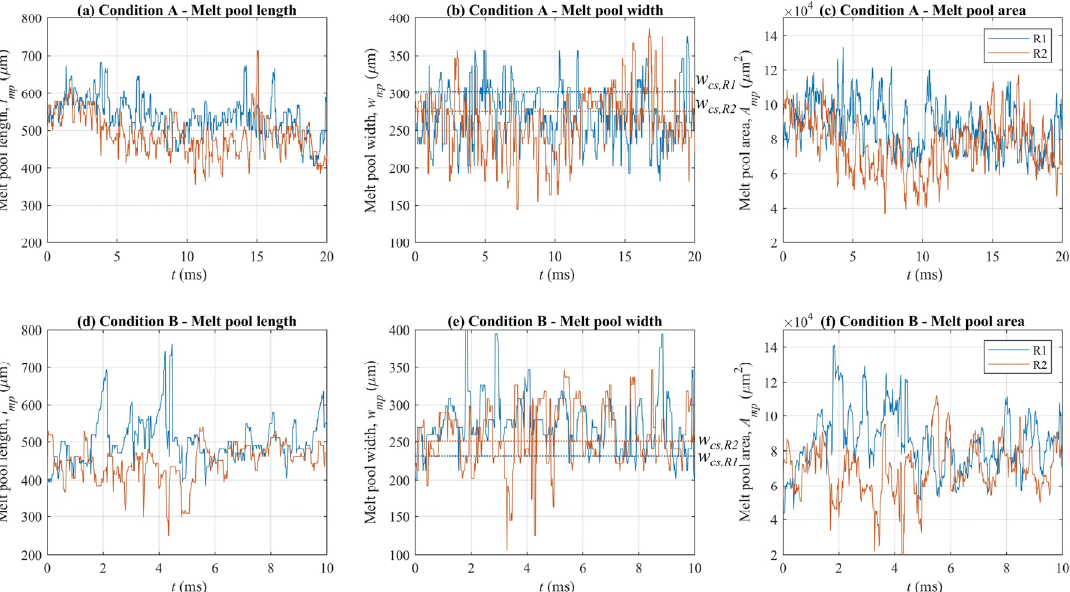
Figure 8. Temporal variation of the different geometrical parameters extracted by means of the image processing algorithm for Condition A, ( a – c ) and for Condition B, ( d – f ). Width from cross-sectional measurements w cs in dashed lines.